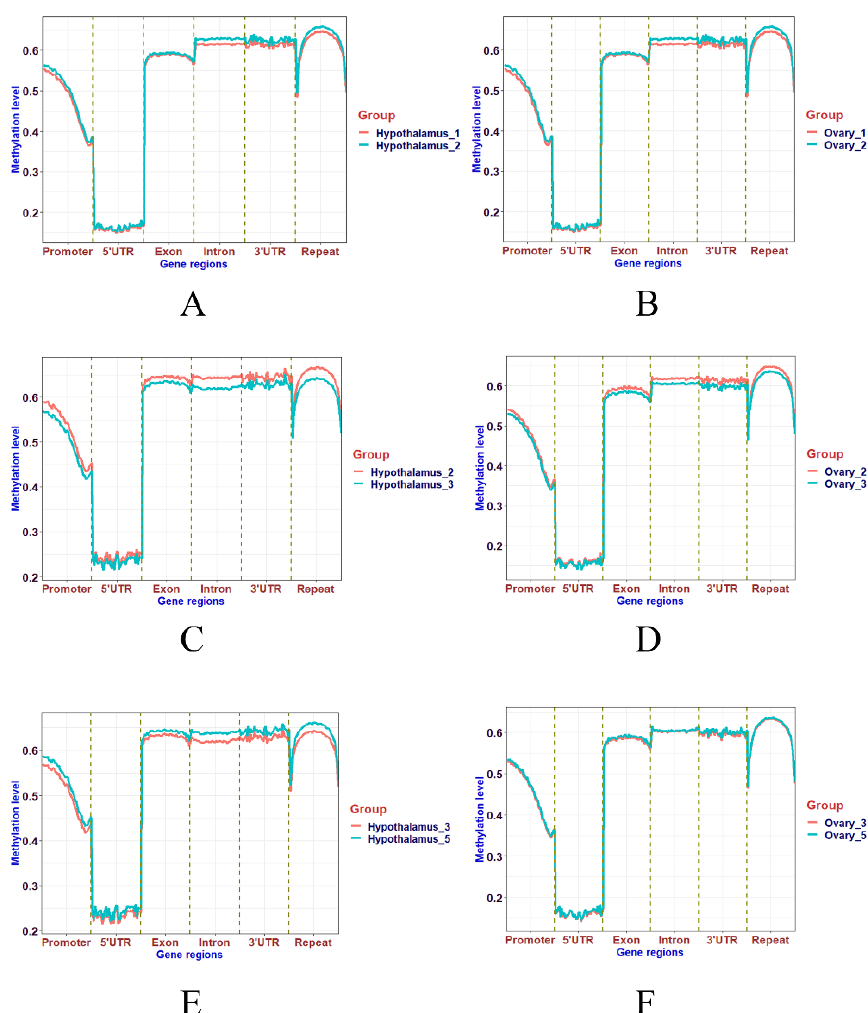
Figure 1. Methylation level at different functional regions in the genome. The horizontal coordinate represents gene functional elements, and the vertical coordinate represents CG-type DNA methylation levels with the hypothalamus ( A ) and ovary ( B ) at group 1-vs.-2, hypothalamus ( C ) and ovary ( D ) at group 2-vs.-3, hypothalamus ( E ) and ovary ( F ) at group 3-vs.-5.